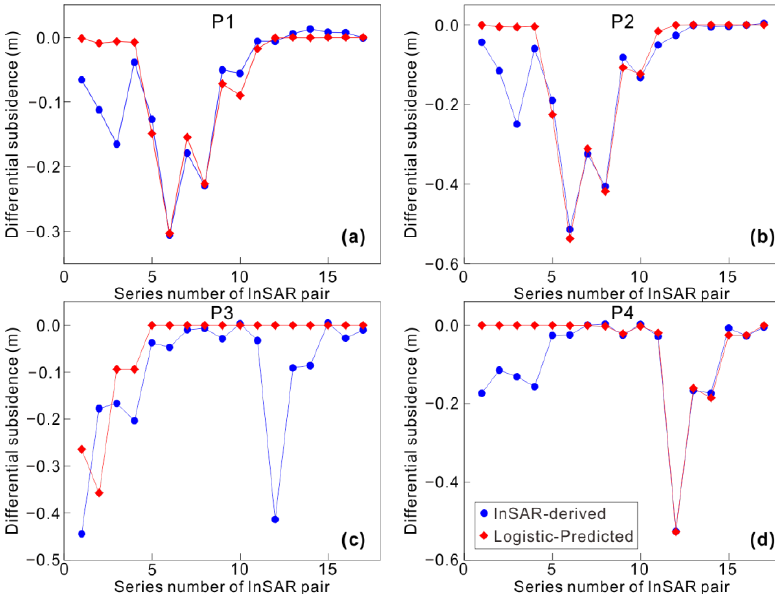
Figure 11. Comparison between the differential subsidence obtained by the InSAR-derived observations and the logistic-estimated synchronous results at points P1 to P4 (their locations are marked by the red points in Figure 8), respectively in ( a – d ).